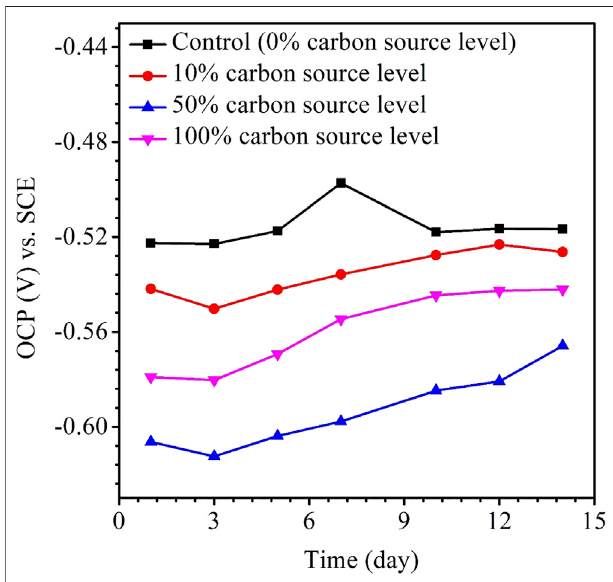
FIGURE 5 | Variations of the OCP vs. time for X80 during 14-days starvation incubation.